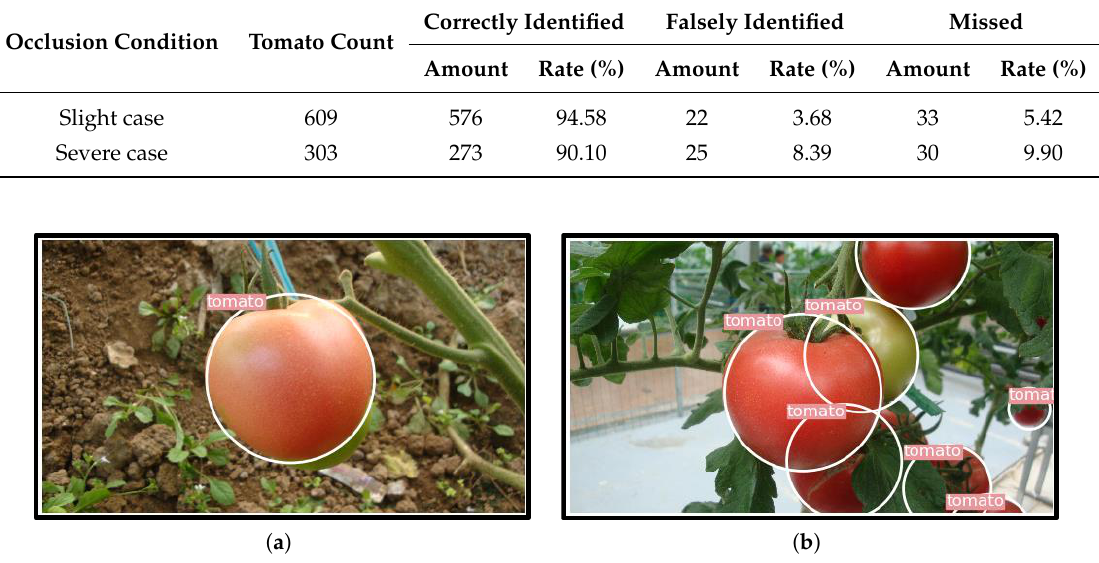
Figure 15. Some missed detection results due to severe occlusion by leaves or other tomatoes: ( a ) the green tomato which was largely covered by the red one was not detected, and ( b ) the red tomato was missed due to severe occlusion by leaves, stems and other